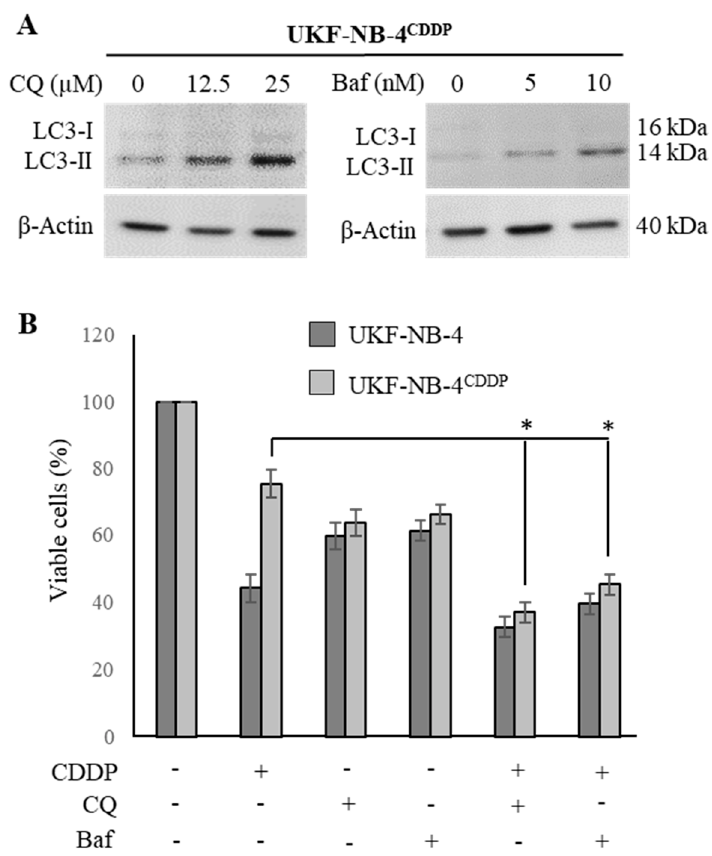
Figure 5. Re-sensitizing of UKF-NB-4 CDDP cells by lysosomotropic agents chloroquine (CQ) and Baf. ( A ) Whole-cell lysates immunoblots demonstrating conversion of LC3-I to LC3-II as a result inhibition of autophagy causing intracellular accumulation of autophagosomes. β -Actin–loading control. ( B ) Trypan blue exclusion data showing the re-sensitizing activity of CQ and Baf in UKF-NB-4 CDDP cells. The data are results from five independent experiments. * p < 0.01 related to CDDP cytotoxicity. +/ − indicates the presence of CDDP, CQ or Baf in the treatment.